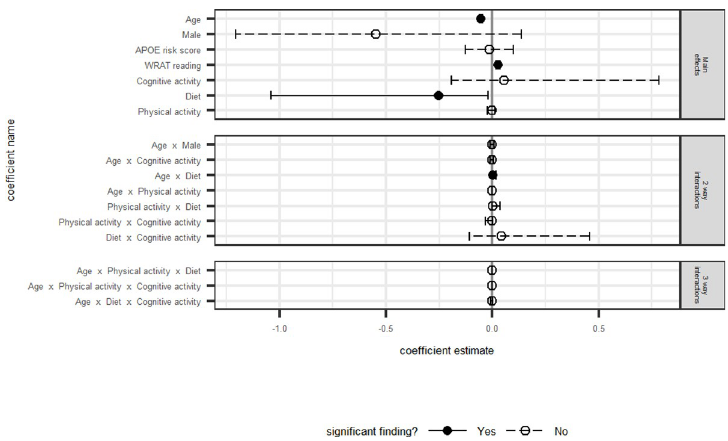
Fig 4. Executive function: Model averaged regression coefficient estimates and 95% confidence intervals.